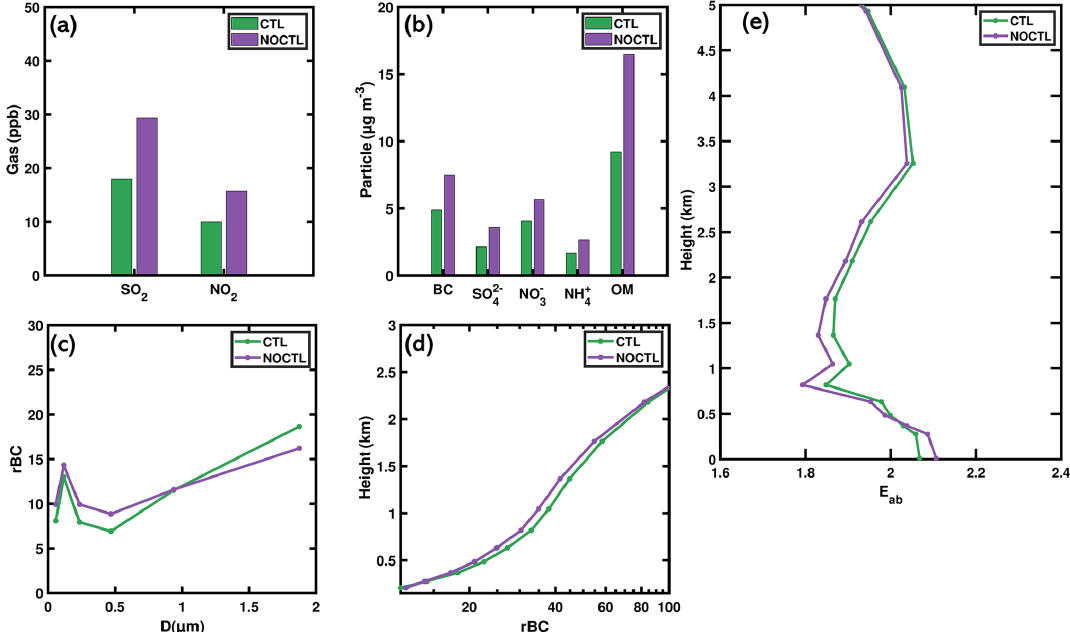
Figure 3. Mass concentrations of gaseous and condensed pollutants in the CTL and NOCTL cases (a–b) ; the distribution of r BC with sizes in the CTL and NOCTL cases (c) ; the distribution of r BC with height in the CTL and NOCTL cases (d) and the distribution of E ab values with height in the CTL and NOCTL cases (e)